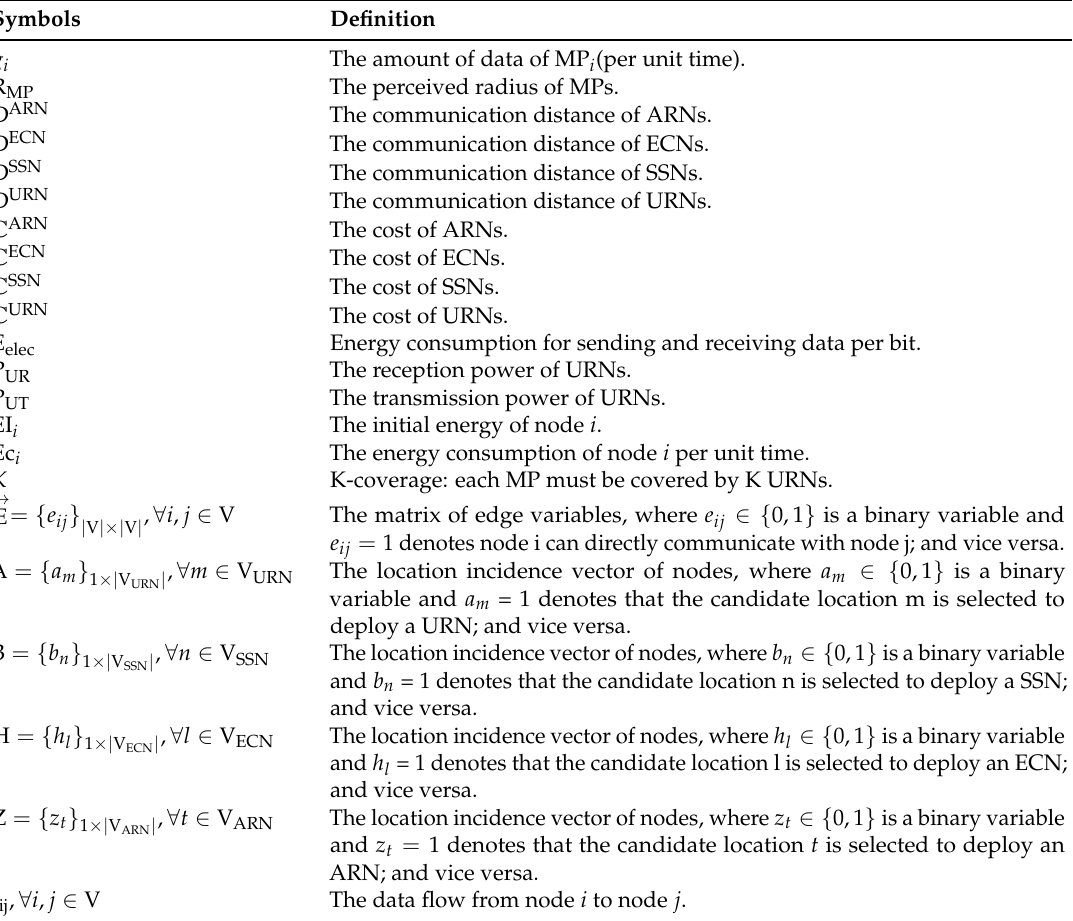
Table 1. Table of